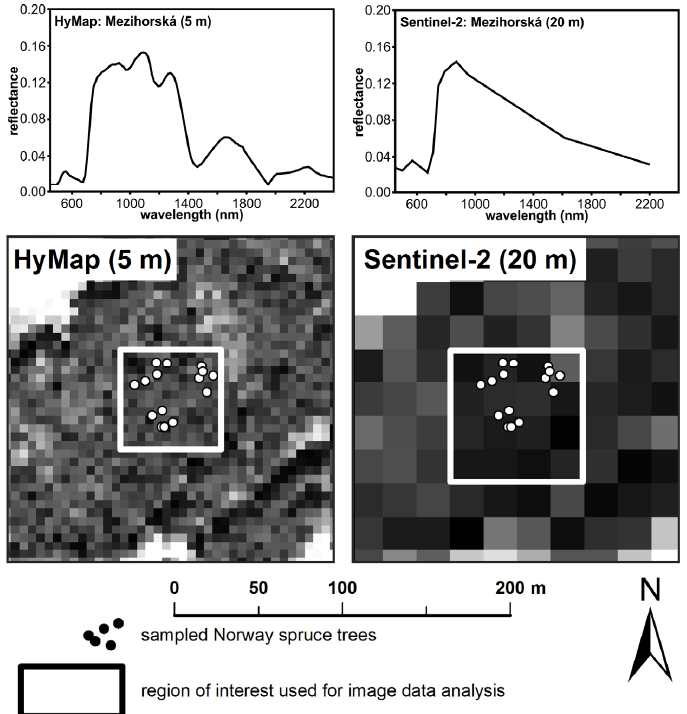
Figure 2. Example (the Mezihorská site) showing the Regions Of Interest (ROI) and the sampling points overlaid on the hyMap ( left ) and simulated Sentinel 2 ( right ). At the top: per-ROI-averaged reflectance derived for HyMap ( left ) and simulated S2 image data ( right ) which was used in the following analyses.